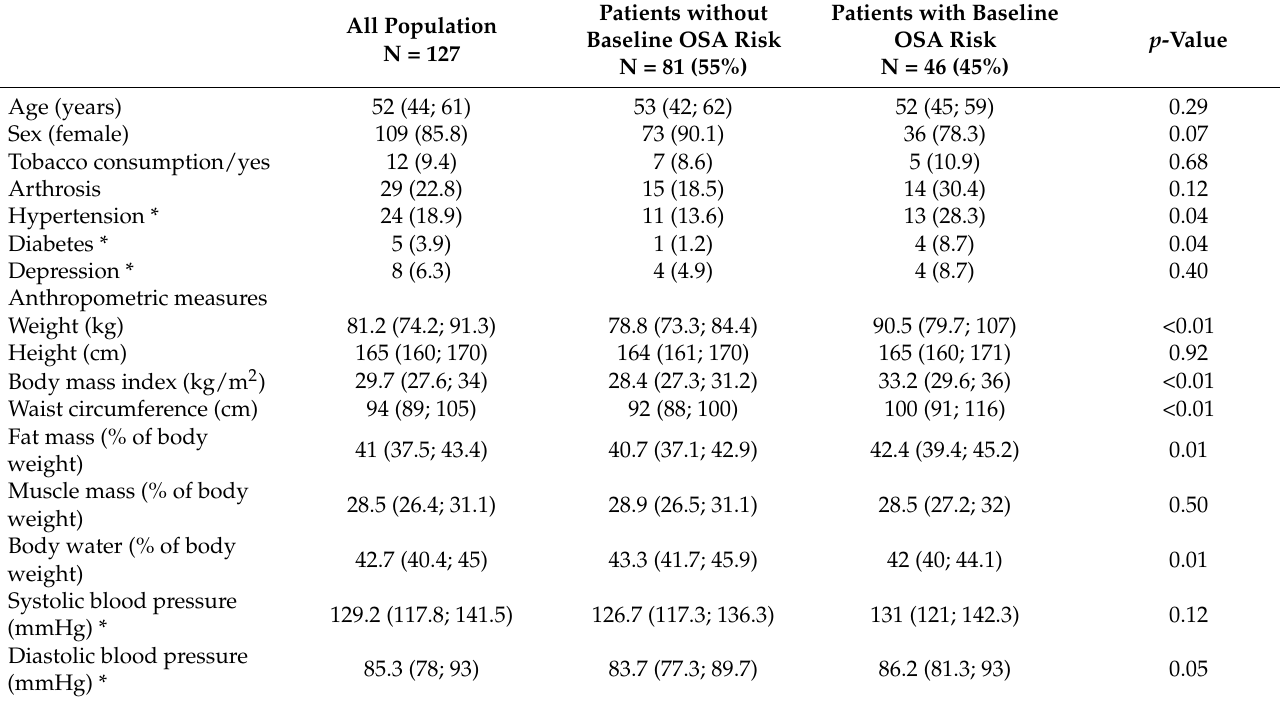
Table 1. Description of baseline patient characteristics and anthropometric measures.